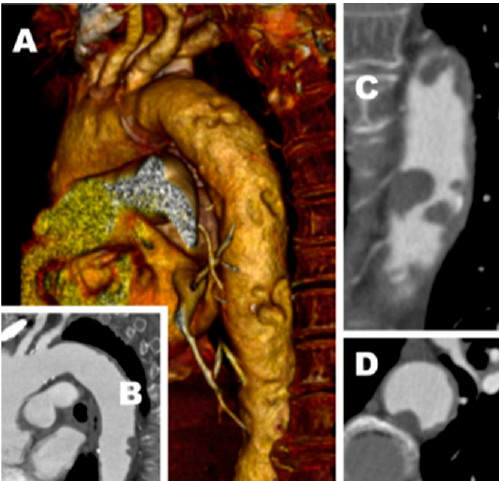
Figure 1. CTA scan revealed ( A ) multiple focal ulcerative embolic plaques, ( B ) minimal injury lesion, ( C ) irregular ulcerative plaque, ( D ) excavated lesion.